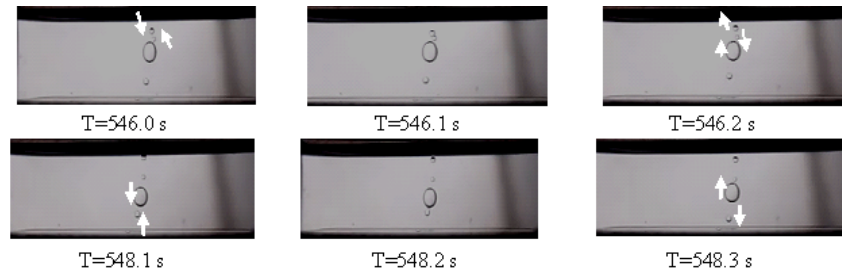
Figure 9. Making a thread due to large elongation and increasing the voltage (Ca E = 0 . 26). Fig. 9. Making a thread due to large elongation and increasing the voltage (Ca